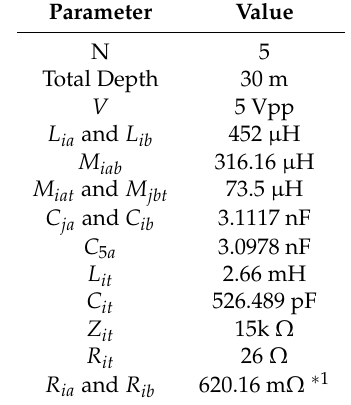
Table 2. Experiment Setup for Frequency Response Evaluation of a network branch with five